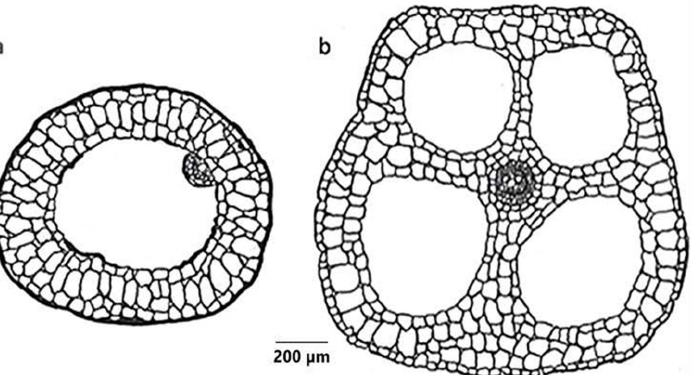
Figure 2. The root ( a ) and leaf ( b ) cross-section of Isoëtes L. sp. with large central air spaces. Drawings: Alenka Gaberš č ik.